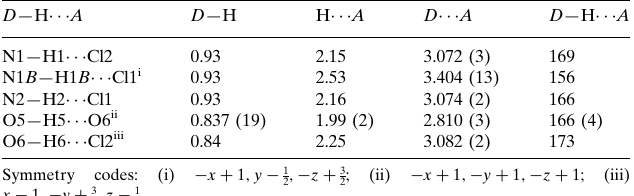
Data collection: APEX2 (Bruker, 2008); cell refinement: SAINT (Bruker, 2008); data reduction: SAINT and CELL NOW (Sheldrick,